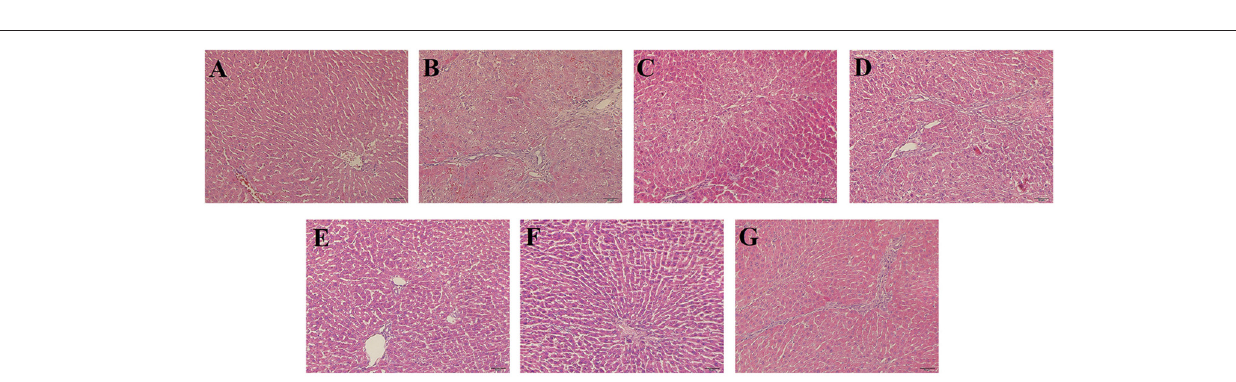
FIGURE 2 | Effects of ZYCH on hepatic histopathological changes of DMN-induced liver injury rats. Hepar sections by hematoxylin-eosin (HE) staining at a magniication of × 100. (A) . control group, (B) . model group, (C) . SC group, (D) . L-ZYCH group, (E) . M-ZYCH group, (F) . H-ZYCH group, and (G) . HR-ZYCH